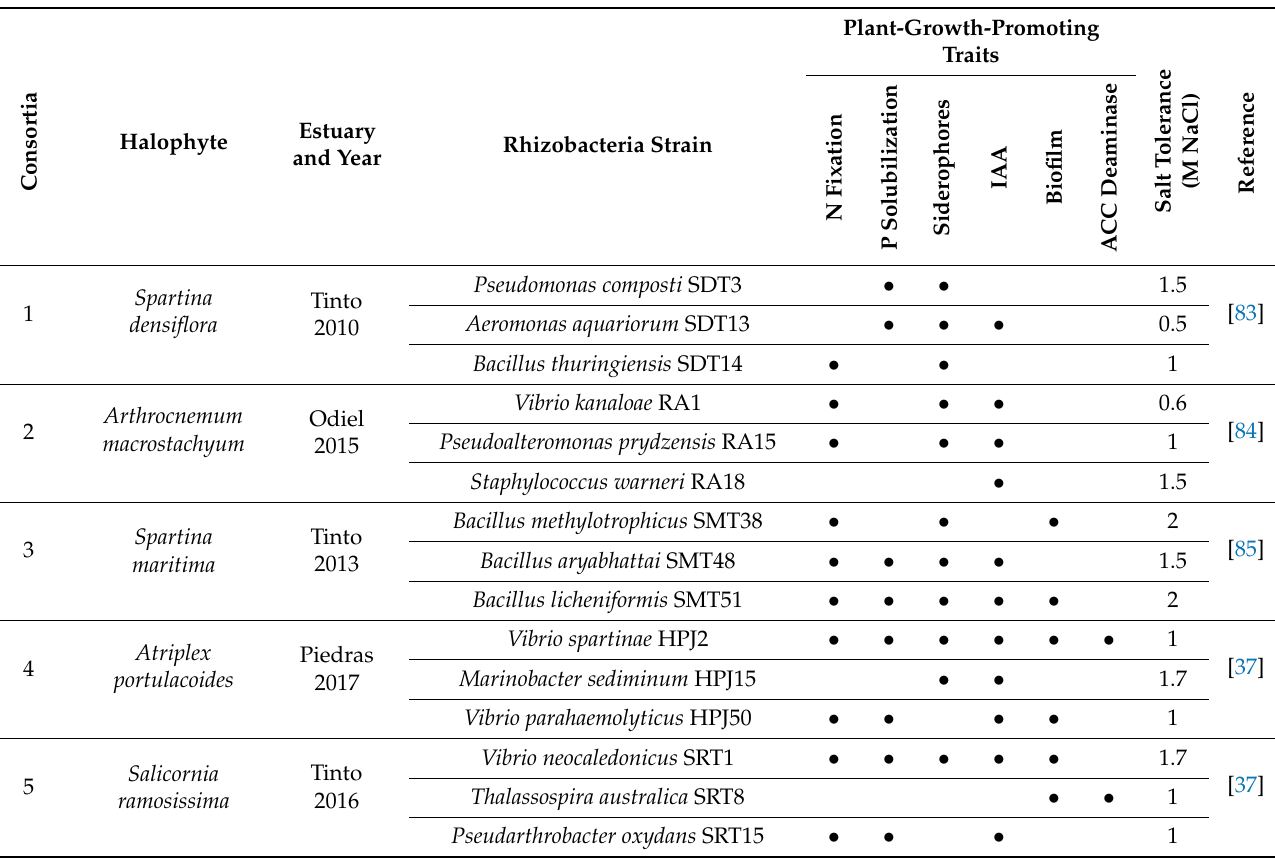
Table 4. Isolation data and traits of the plant-growth-promoting rhizobacteria (PGPR) used in this